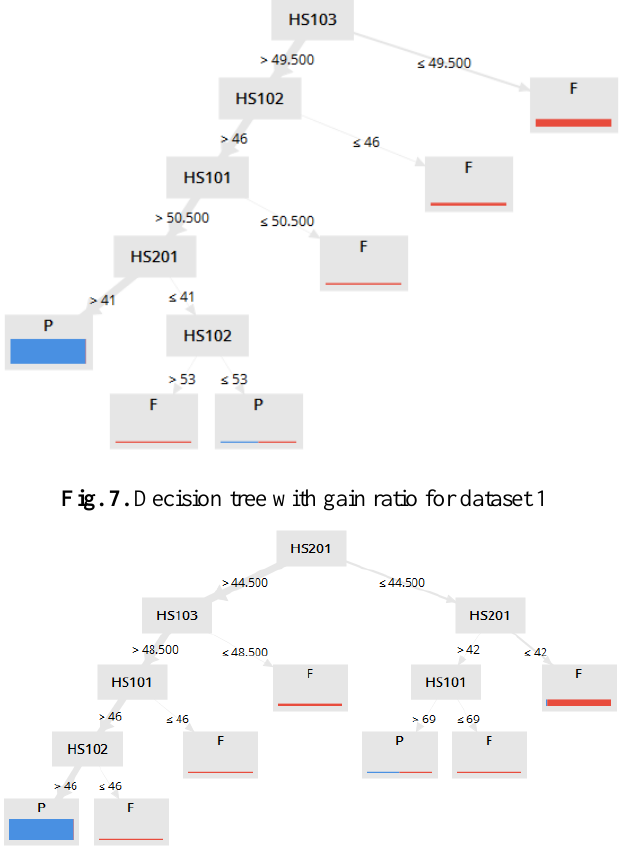
Fig. 8. Decision tree with Gini index for dataset 1